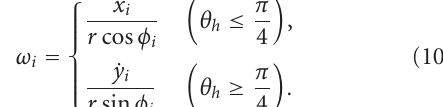
Figure 4: ExoMars rover and given trajectory represented in the Fr´enet